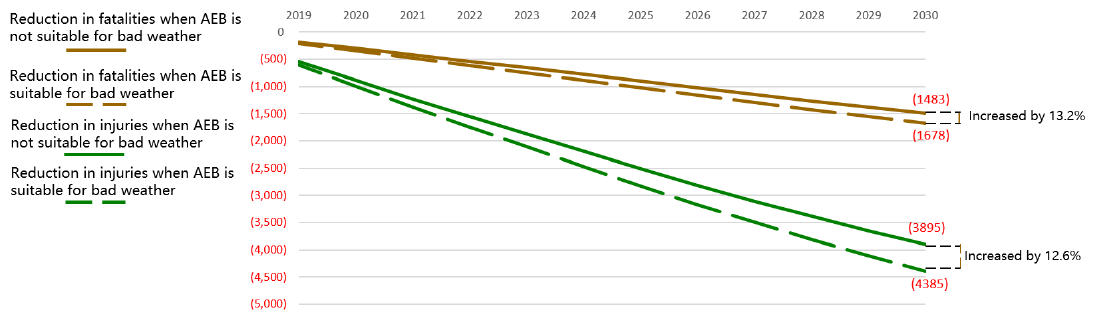
Figure 7. Reduction in fatalities and injuries in China with different weather suitability.